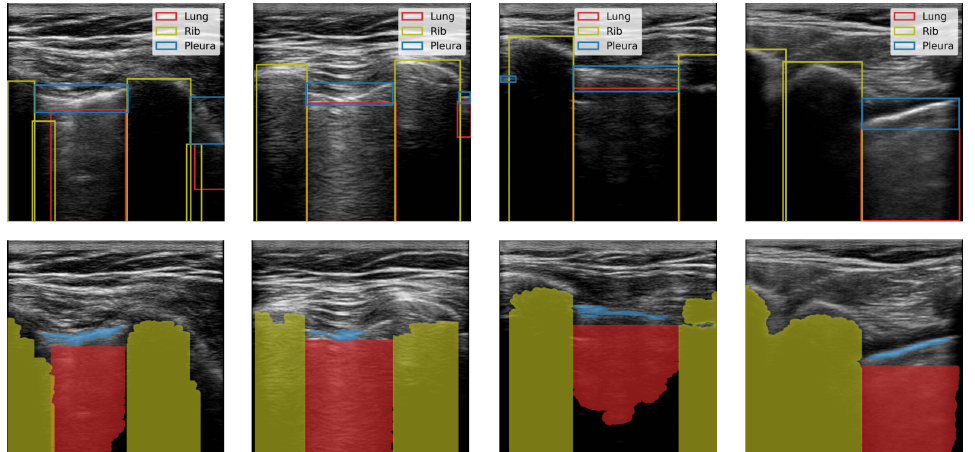
Figure 2. Creation of semantic masks for the pleura, lung, and rib from labelled data. Top : Bounding boxes labelled by volunteers. Bottom : Semantic masks generated from the bounding boxes.